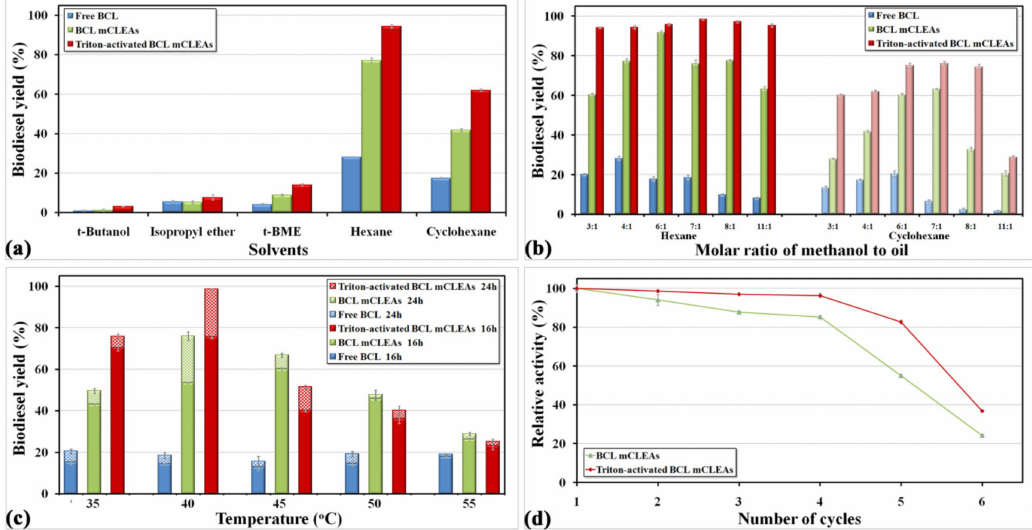
Figure 7. Reaction parameters on biodiesel production catalyzed by free BCL, BCL mCLEAs and Trion-activated BCL mCLEAs and reusability of immobilized BCL. ( a ) Solvents, ( b ) molar ratio of methanol to oil, ( c ) temperature, ( d )